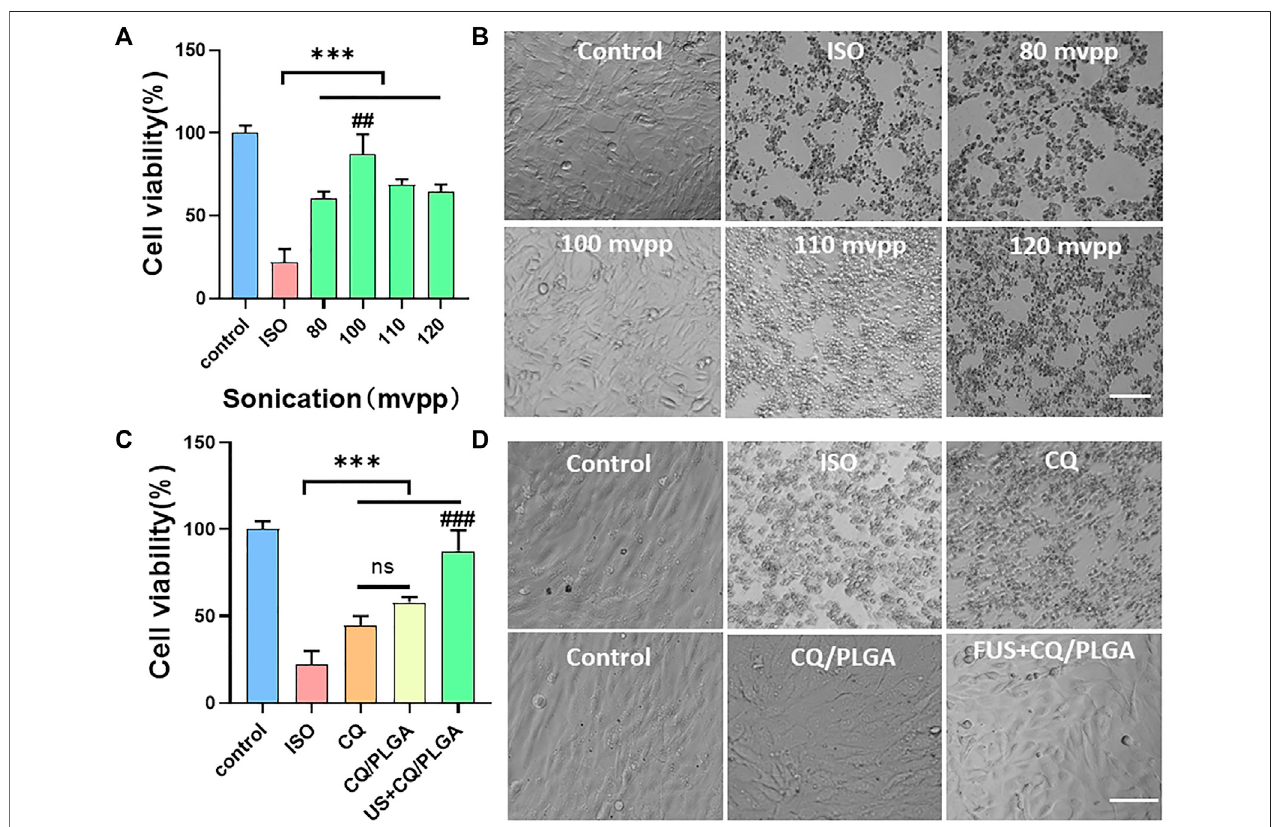
FIGURE 7 | Evaluation of the inhibitory effect of ultrasound combined with CQ/PLGA on ferroptosis in HL-1 via CCK-8 detection. (A,B) When the fusion degree of HL-1 cells reaches 80%, the culture medium containing ISO (concentration of 2 mM) and CQ/PLGA (concentration of fi nal drug of CQ is 80 μ g/ml) is added and treated withultrasoundfor30s(ultrasound intensityis0,80,100,110, and120mvpp),inwhichthecontrolgroupdoesnotdoany treatment.After24hofincubation, theviability of cells was detected using the CCK-8 reagent, and the survival status of cells was observed under a microscope. When the intensity of ultrasound is 100 mvpp, ultrasound combined with CQ/PLGA has the best effect on inhibiting the occurrence of ferroptosis in HL-1. The cell viability was 87.39% ± 10.64% (vs. “ ISO group, ” *** p < 0.001, vs. other groups, ## p < 0.01, n = 5, Bar = 50 µm). (C,D) When the fusion degree of HL-1 cells reached 80%, the HL-1 cells were treated with different treatmentsandincubatedfor24h.TheresultsshowedthatultrasoundcombinedwithCQ/PLGAcouldbetterinhibittheferroptosisprocessofHL-1causedbyISO.The cell viability of the ISO group was 22.11% ± 7.02%, and the cell viability of ultrasound combined with the CQ/PLGA group was 83.16% ± 7.21% (vs. “ ISO group, ” vs. other groups, ### p < 0.001, n = 5, Bar = 50 µm).